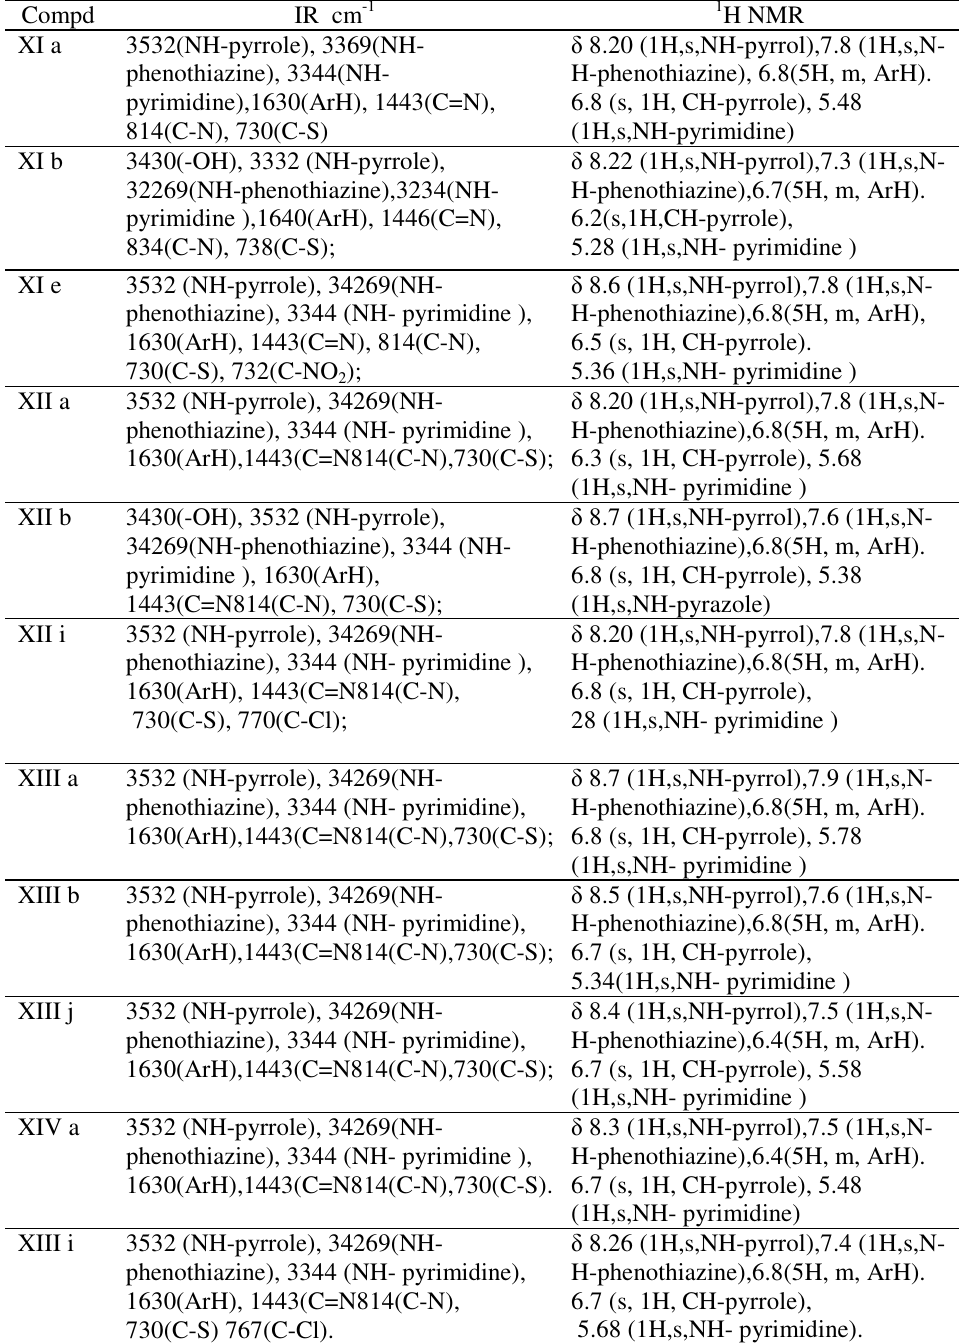
Table 1 . Characterization data of compounds (XI a-j) Compd IR cm